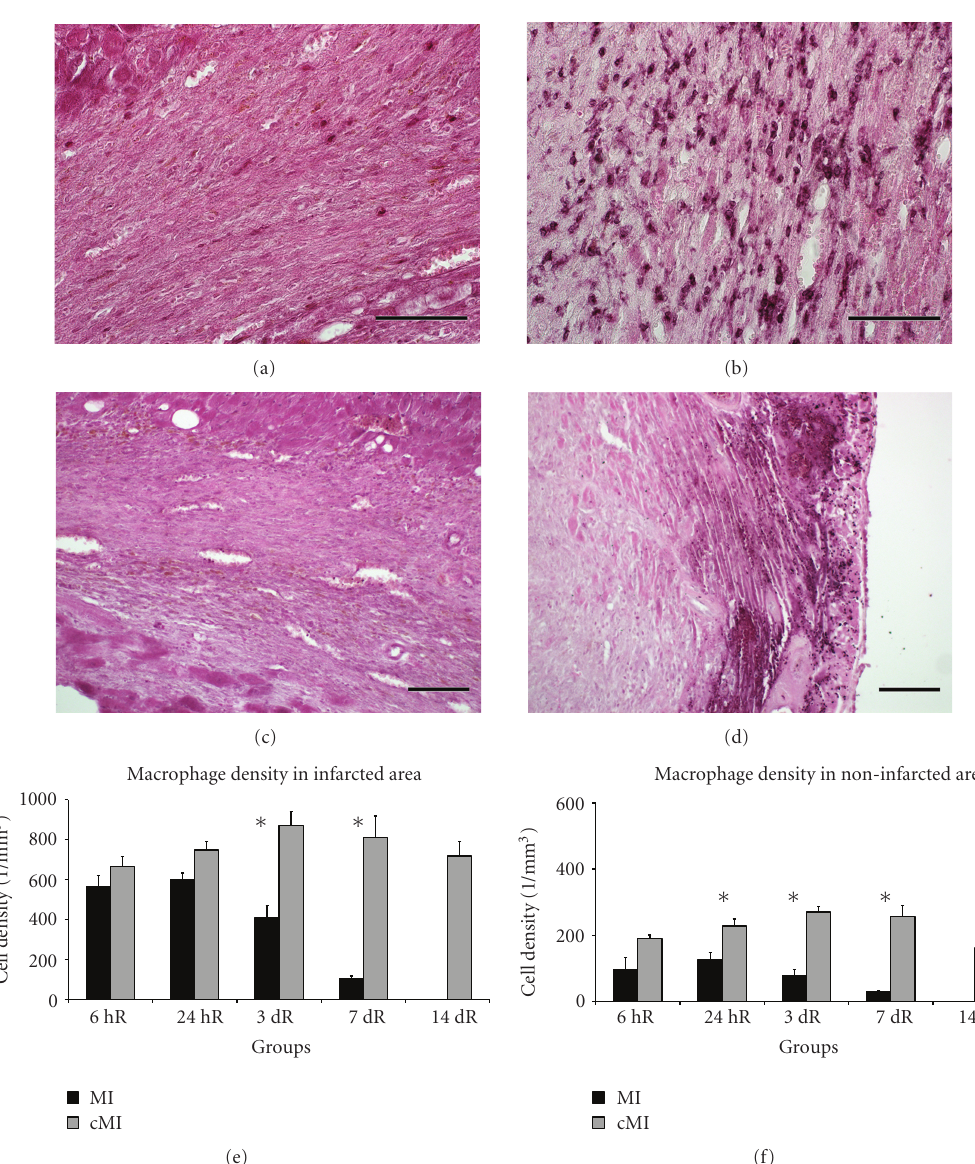
Figure 3: Macrophage density in cryoinfarction and reperfused infarction. Representative F4/80 staining for macrophages (black-stained cells) in left ventricular wall (pink eosin counterstaining) 7 days after (a) reperfused infarction (MI) and (b) cryoinfarction (cMI). Elastase staining showed lack of macrophage activity after 7 days in (c) MI in contrast to (d) ongoing activity (black staining) in cMI (pink eosin counterstaining). Comparison of macrophage cell density in (e) infarcted area and (f) noninfarcted area in both models. Scale bar (a)-(b): 75 μ m, (c)-(d): 100 μ m; ∗ P < .